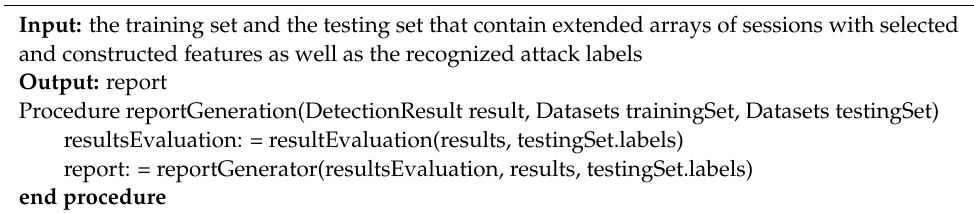
Algorithm 4. Result formation